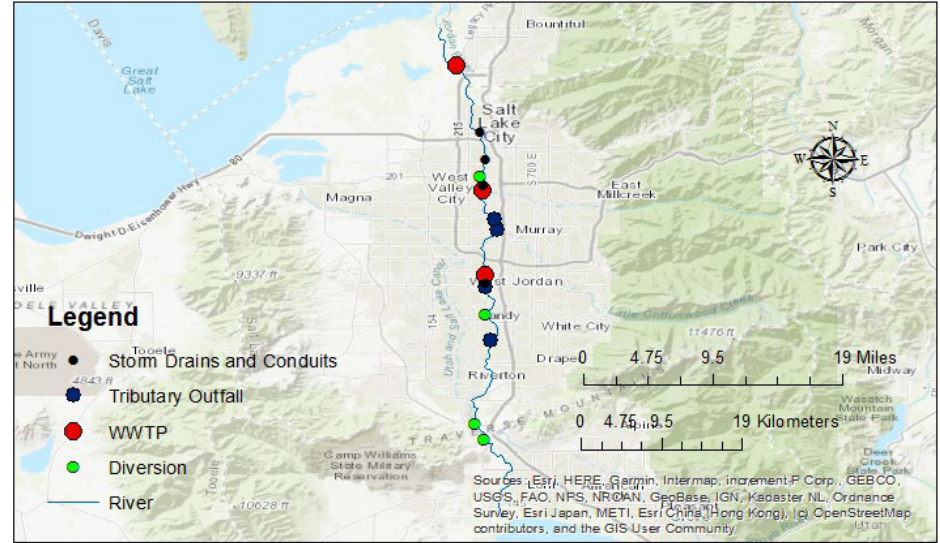
Figure 1. Jordan River System in Salt Lake City, UT, with all Associated Diversions, WWTPs, Tributaries, Storm Drains and Conduits.